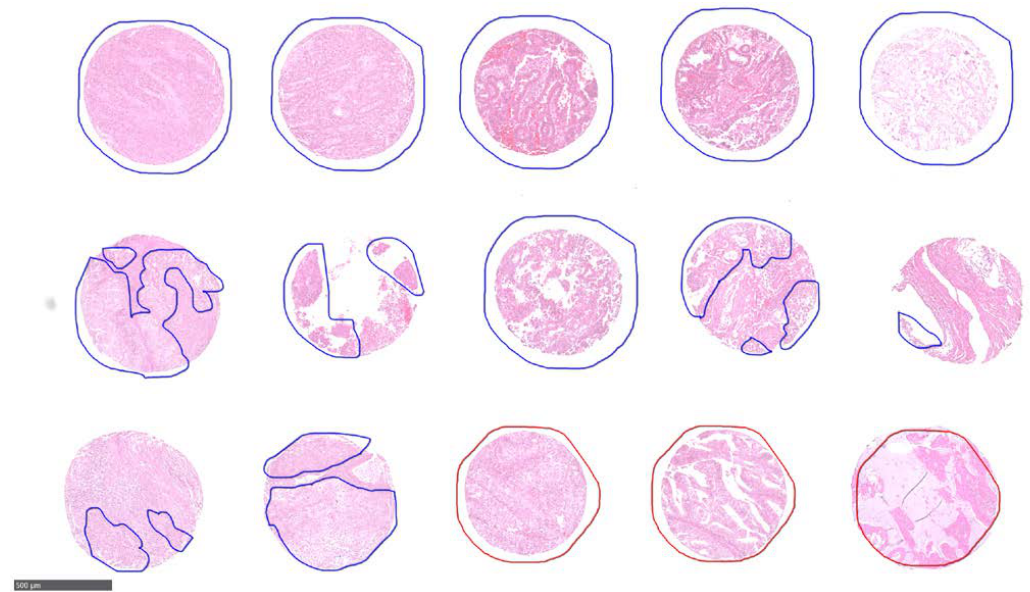
Figure 2. Representative zoomed in annotated EC TMA. Each patient had either two or four tissue cores, with pathologist annotated regions outlined in blue or red. Tissue cores from patients with LNM are annotated in red while blue are regions without LNM. Scale bar is 500 µm.